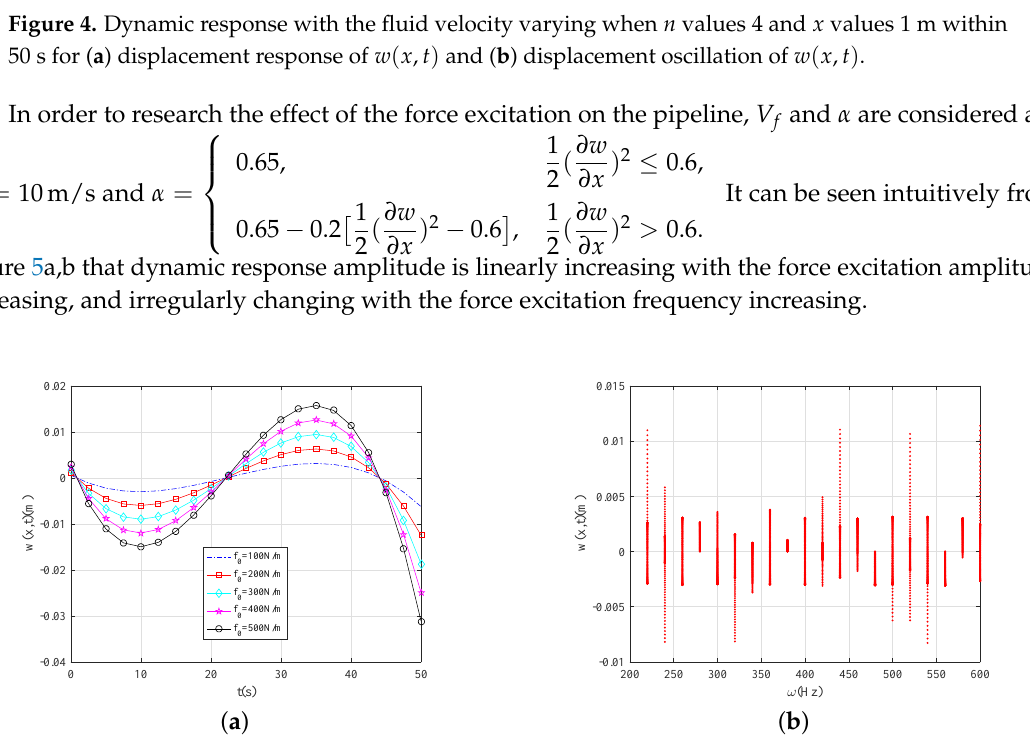
Figure 5. Dynamic response with the force excitation varying when n values 4 and x values 1 m within 50 s for ( a ) excitation amplitude f 0 and ( b ) excitation frequency ω